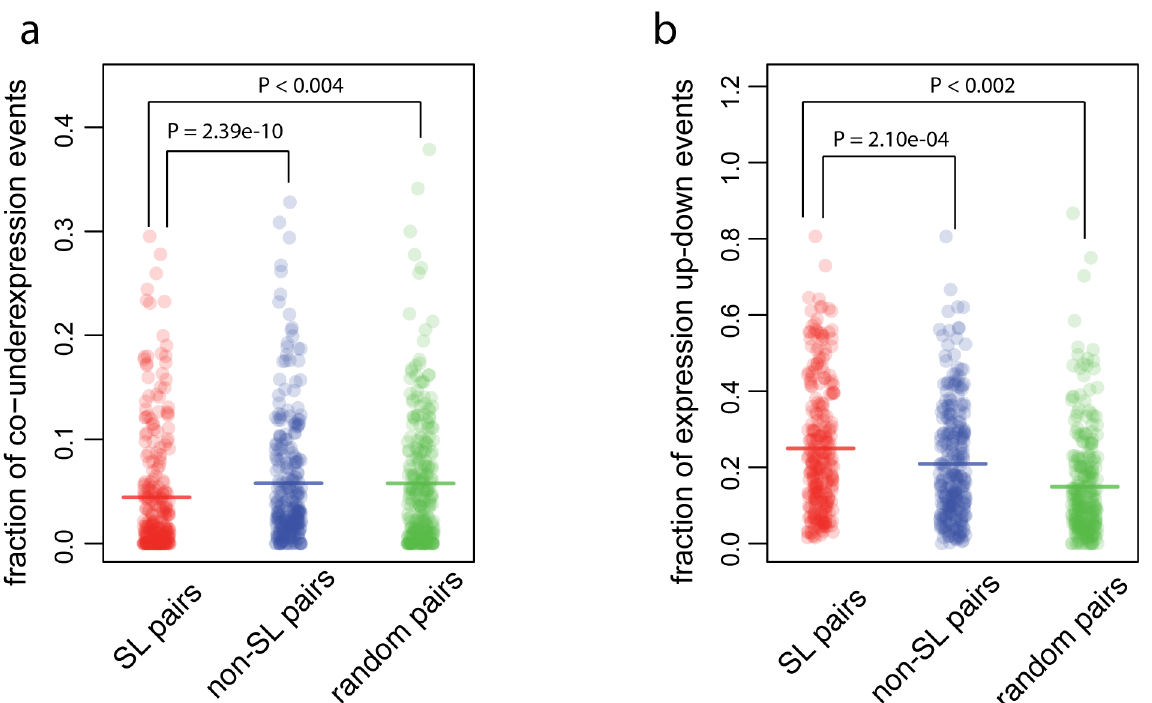
Fig 3. SL pairs are reflected in gene expression variations. (a) SL pairs are less likely to be co-underexpressed relative to the control i.e., non-SL or random pairs. The fraction for co-underexpression events is described as f 4 in methods and Fig 1. (b) SL pairs are more likely to have expression up-down events where one gene is over-expressed while the other in under-expressed. The fraction for such pattern is described as f 5 in Methods and Fig 1. Each dot is the fraction for a given pair and the horizontal bar represents the mean of the fractions. P-values for the comparison between SL and non-SL pairs were calculated with a one-sided Wilcoxon rank test. P-values for the comparison between SL and random pairs were calculated from 1000 randomizations. P- values were adjusted for multiple comparisons using the Bonferroni correction (for details see